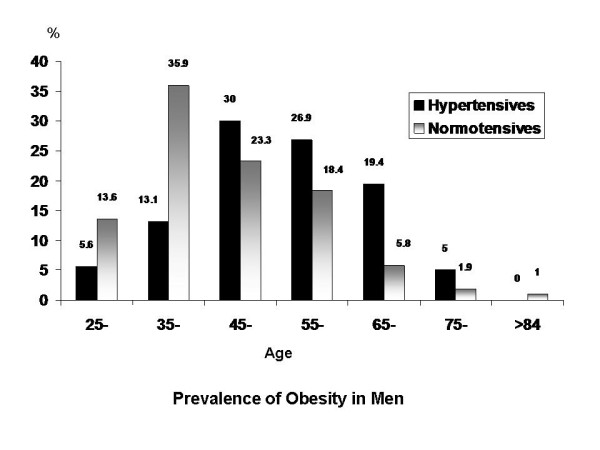
Prevalence of Abdominal Obesity(%) in Different Age Decades in Normotensive and Hypertensive Men.